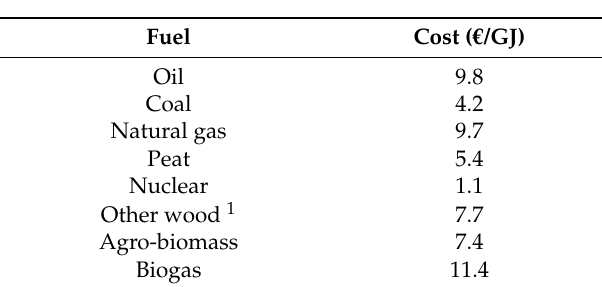
Table A2. Assumed fuel costs (excl. taxes) in 2050, based on References [54,75–77]. Fuels not listed are assumed to have zero costs.